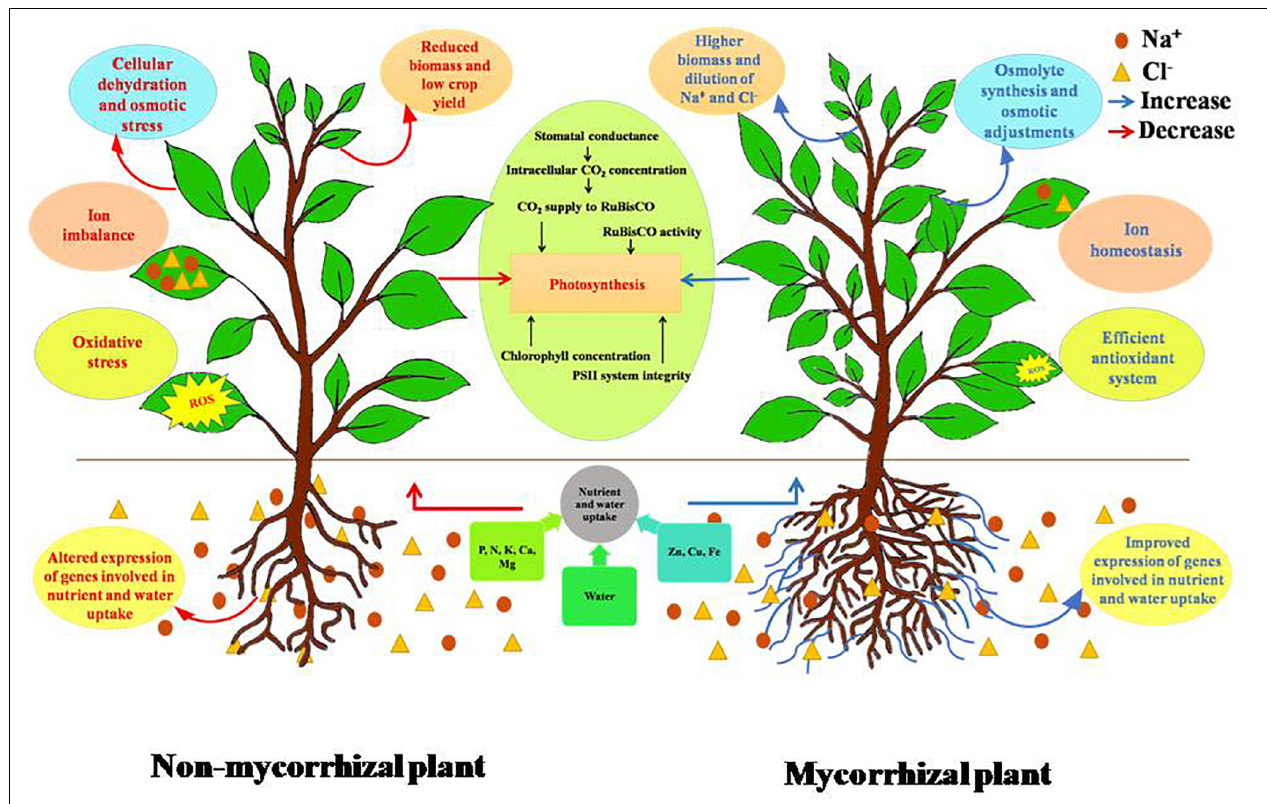
FIGURE 1 | Differential response of non-mycorrhizal and mycorrhizal plants under salt stress. Accumulation of salt in soil creates competition for nutrient uptake and transport. This leads to imbalance of the ionic composition of plant, thereby affecting plant’s physiological traits. AMF increase the volume of soil explored by plant roots, upregulate several cation transporters, leading to improved nutrient uptake, and also maintains ionic homeostasis. Salinity lowers soil water potential causing cellular dehydration due to decrease in water uptake. AM negates this effect by mediating accumulation of osmolytes and also improves plant’s water status by improving root hydraulic conductivity. Salinity induces oxidative stress due to imbalance in ROS (reactive oxygen species) generation and the quenching activities of antioxidants. AMF are known to improve both enzymatic and non-enzymatic antioxidant systems of plants. Photosynthesis is also negatively affected by salinity. AM has a positive effect on photosynthesis under salt stress. Overall, AMF improve the performance of plant under salt